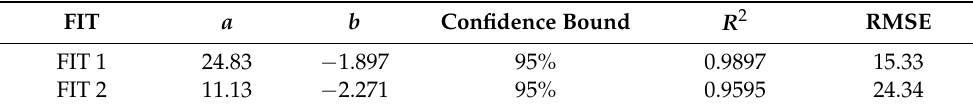
Table 2. Fitting parameters and confidence values.